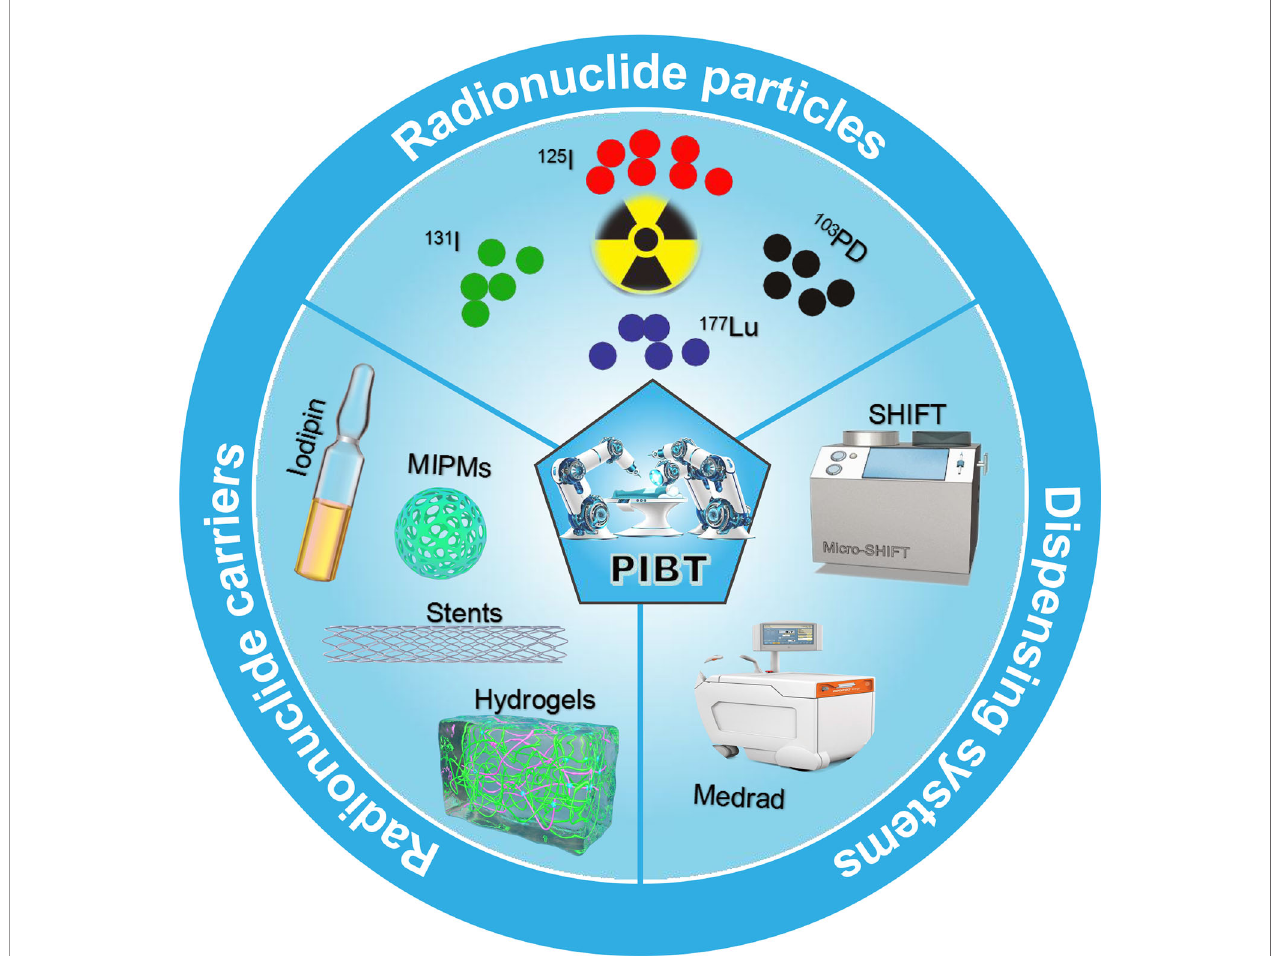
FIGURE 1 | Schematic showing radionuclide particles, radionuclide carriers, and dispensing systems commonly used in interventional